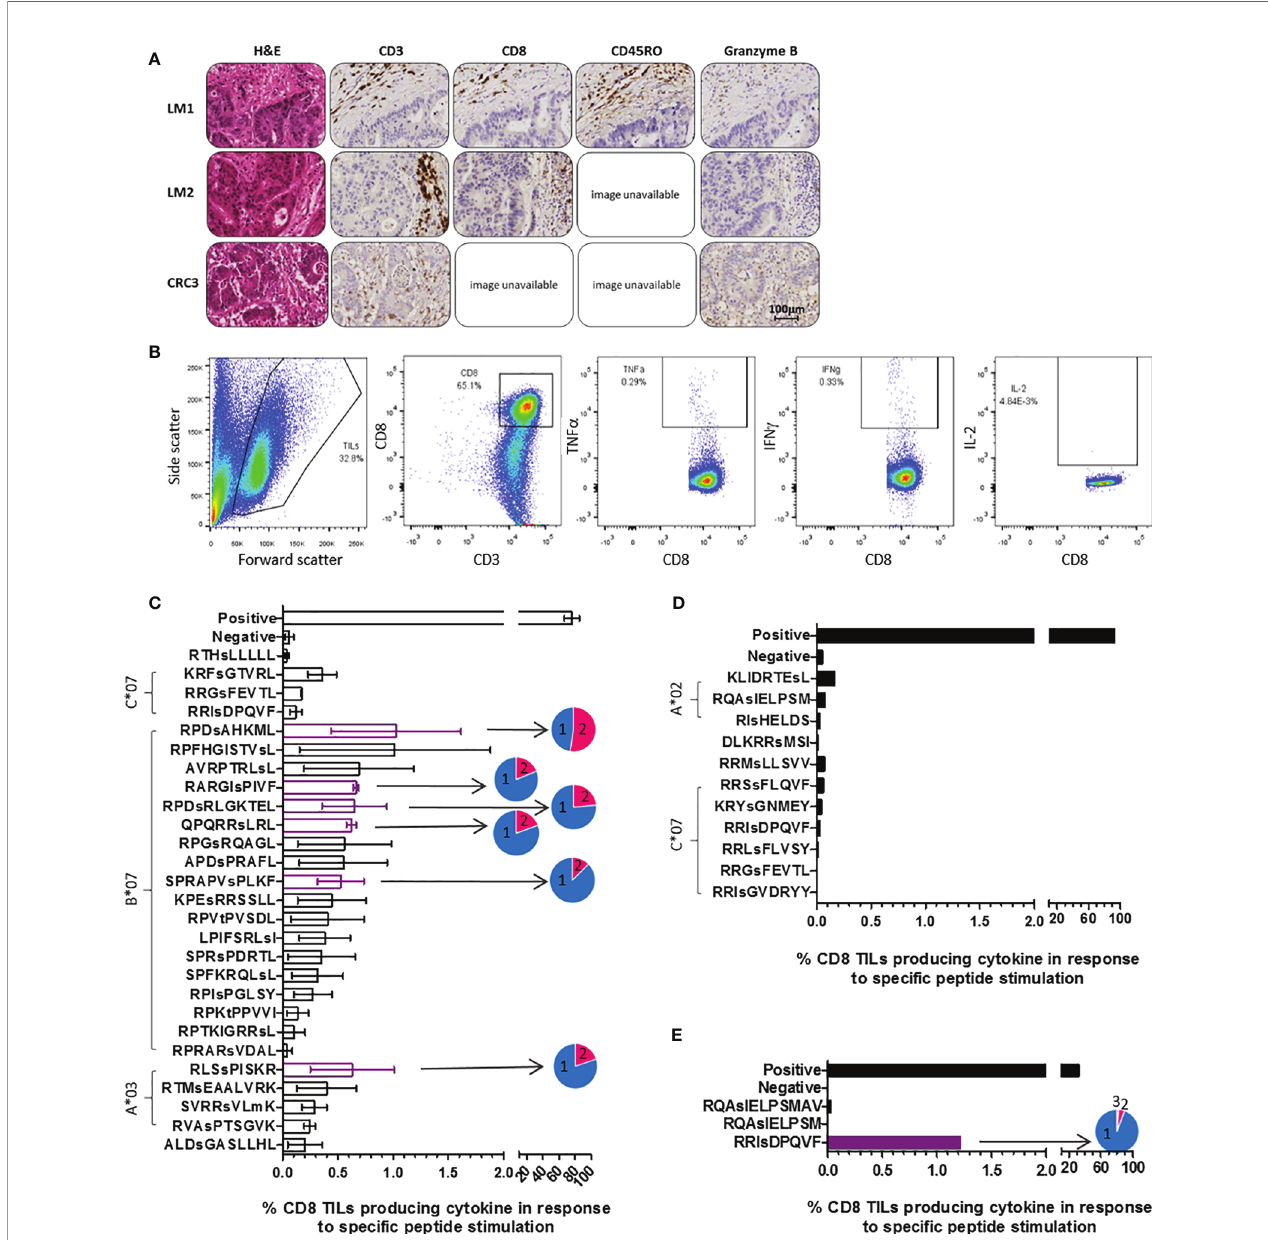
FIGURE 3 | TILs target phosphopeptides found on CRC tumors. (A) Immunohistochemistry (IHC) of the tumors that TILs were taken from, stained for CD3, CD8, CD45RO and Granzyme B (DAB staining in brown). Some slide images unavailable due to loss of section. (B) ICS gating strategy utilized in assessment of TIL phosphopeptide responses. (C) CRCLM1 TIL cytokine responses to phosphopeptides identi fi ed on CRCLM1 (results represent the assay repeated on 2 separate occasions, with differentially expanded TILs), pie charts show the proportion of T cells producing 1 (blue), 2 (pink) and 3 (purple) cytokines. Consistently strong responses are highlighted in purple. (D) CRCLM2 TIL cytokine responses to phosphopeptides identi fi ed on CRCLM2. (E) CRC3 TIL cytokine responses to phosphopeptides identi fi ed on CRC3, pie chart shows the proportion of T cells producing 1 (blue), 2 (pink) and 3 (purple)